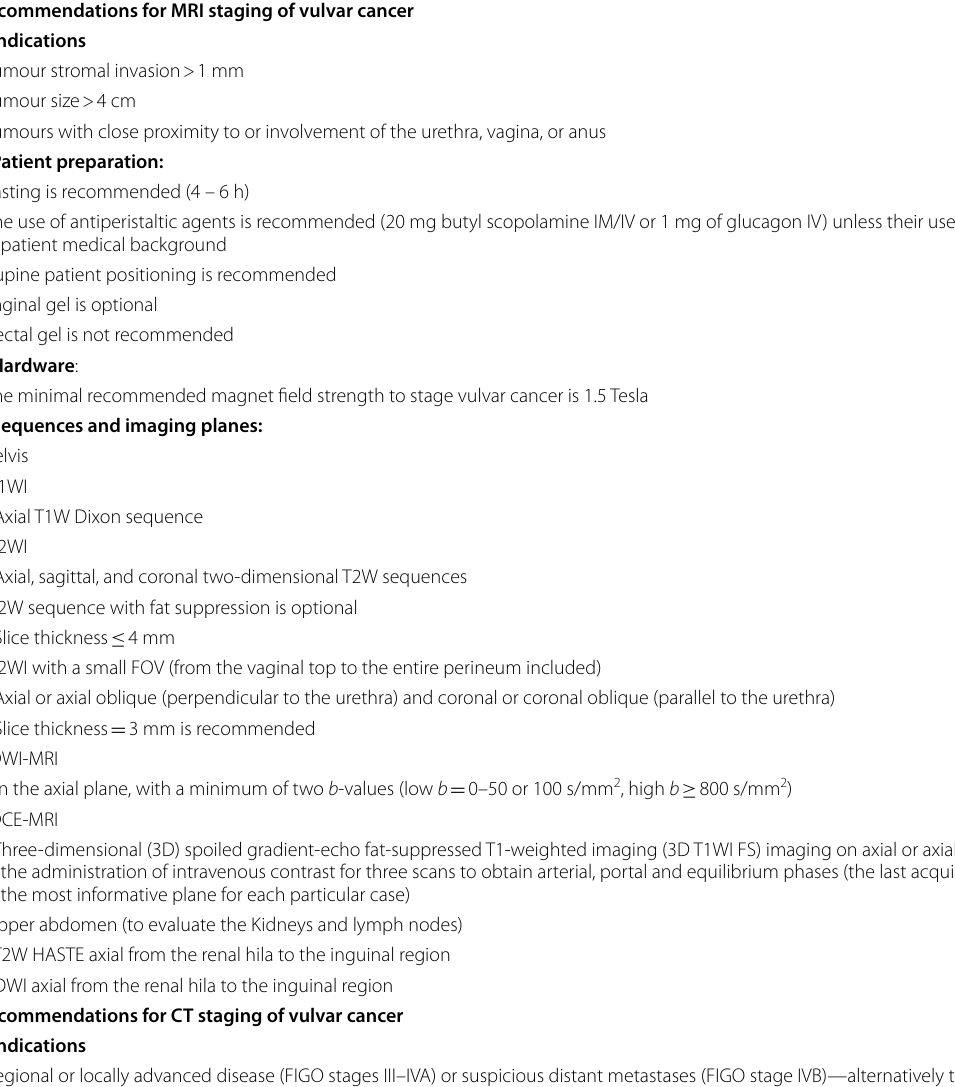
80% agreement among ≥